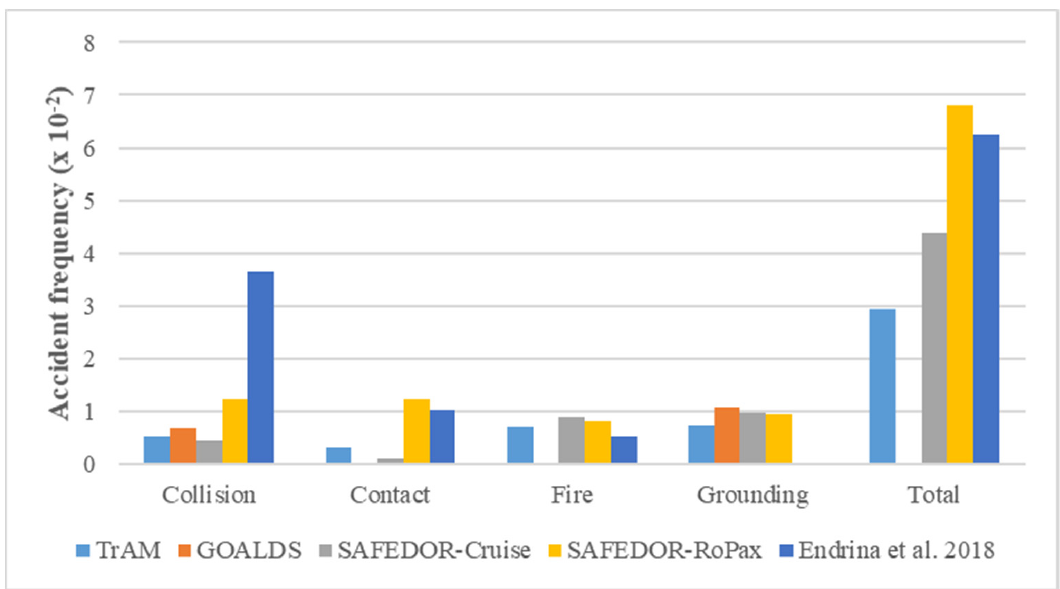
Figure 11. Comparison of accident frequency results between this study and existing projects. Table 13. Number of inland waterways ferries in service vs. year.